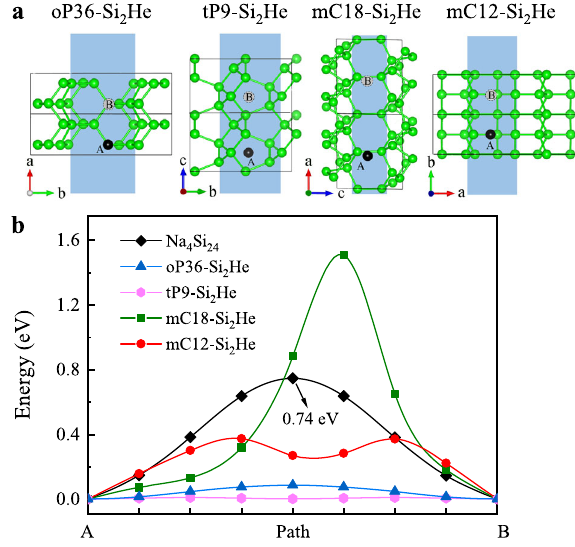
Fig. 3 Migration pathways and energy barriers. a Migration pathways of He atoms from site A to site B along the channels in oP36-Si 2 He, tP9-Si 2 He, mC18-Si 2 He, and mC12-Si 2 He. The shaded regions indicate the longitudinal section of the channels. b Energy barriers for He migration along the channels at zero pressure, as well as Na migration in Na 4 Si 2434 .